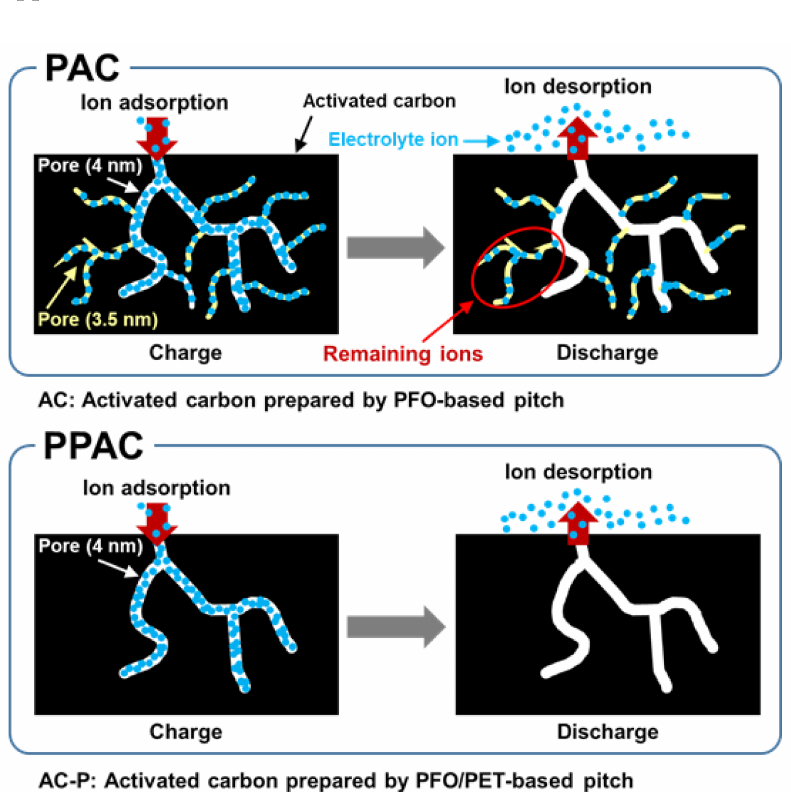
Figure A1. Schematic illustration showing proposed ion storage and expulsion behavior of PAC and PPAC